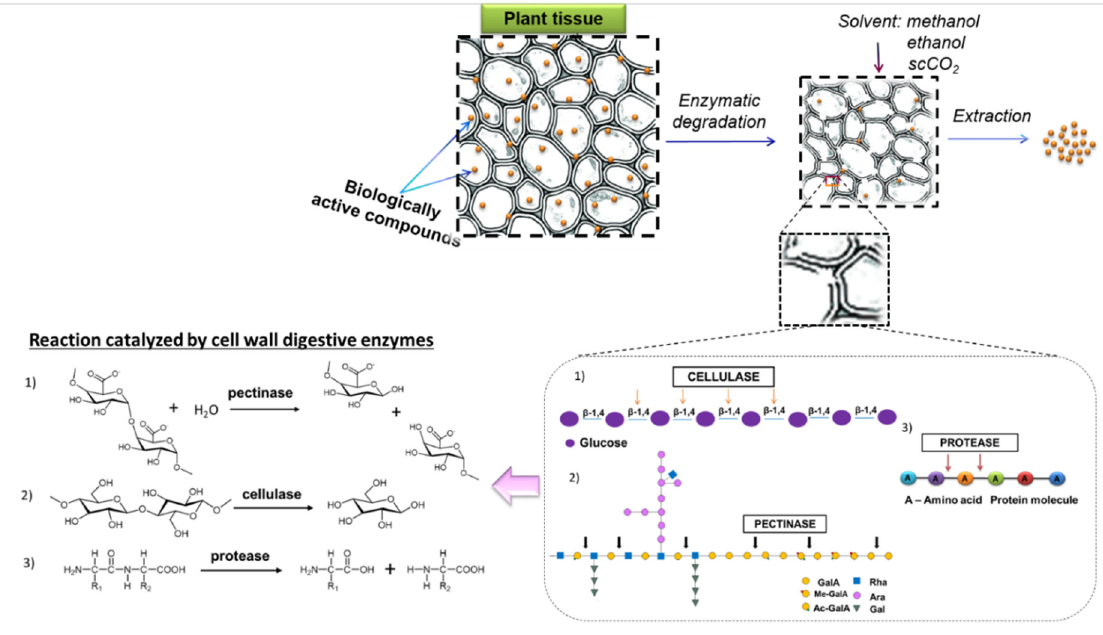
Figure 3. Scheme of enzymatic hydrolysis of plant cells prior solvent extraction.